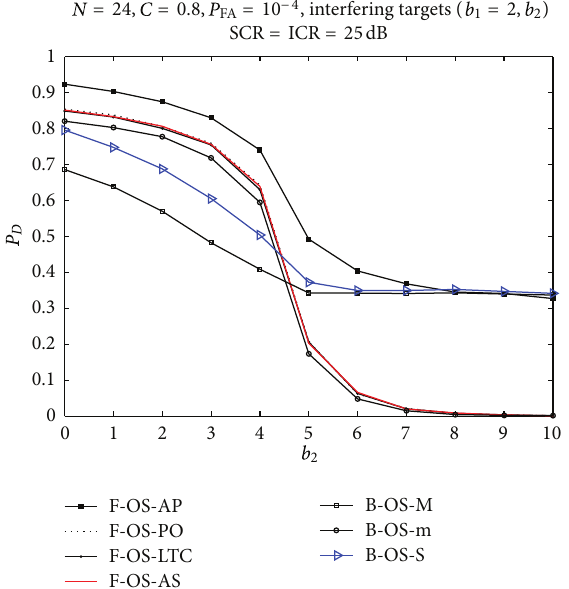
F 10: Detection performance of distributed detector based on OS CFAR algorithm versus number